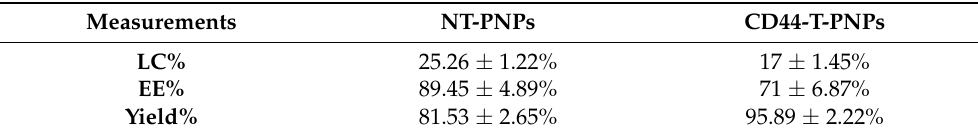
Table 1. The loading capacity (LC%), encapsulation efficiency (EE%), and formulations yield. The CFM-4.16 LC% and EE% was determined in the NT-PNPs and CD44-T-PNPs by HPLC . Also, the formulations were weighted for yield %. Data are presented as mean ± SD, n = 3.